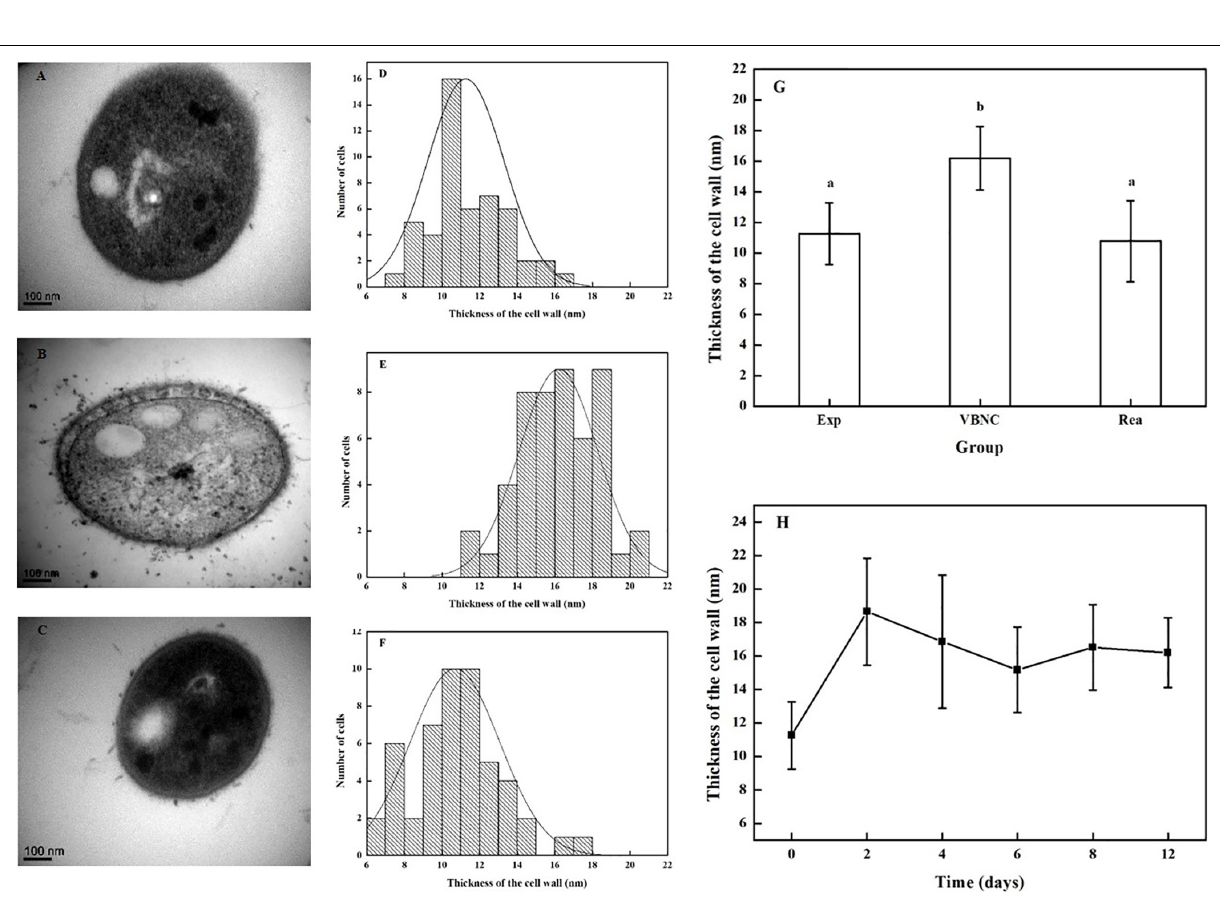
FIGURE 2 | Change in the thickness of cells walls in R. biphenylivorans TG9 cells in the exponential phase, the VBNC state, and after resuscitation. TEM image of (A) exponential cells, (B) VBNC cells, and (C) resuscitated cells. The cell wall thickness distribution of (D) exponential cells ( n = 50), (E) VBNC cells ( n = 50), and (F) resuscitated cells ( n = 50). (G) The thickness of the cell walls of R. biphenylivorans TG9 cells in the exponential phase, the VBNC state, and after resuscitation; Significant differences between means are indicated by different letters, p < 0.05. (H) Change in the thickness of cell walls during the induction of R. biphenylivorans into the VBNC state by treatment with